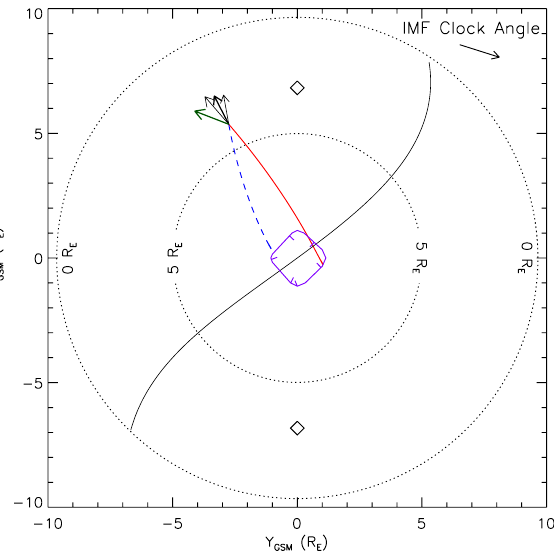
Fig. 10. ( a : left) PEACE electron data from Cluster 2 for FTE 167 (8 April 2003, 03:57 UT). The top three panels are spectrograms showing the differential energy flux of electrons moving parallel, perpendicular and antiparallel to the magnetic field respectively. The bottom two panels show the normal component of the magnetic field and the magnetic field strength observed by all four spacecraft in standard Cluster colours (C1: black, C2: red, C3: green, C4: blue). This event is an exam- ple of a straightforward electron signature (accelerated magne- tosheath plasma antiparallel to the magnetic field, indicating a connection to the Northern Hemisphere). ( b : above) The Cool- ing model run for this event, in the same format as Fig. 7. The observed velocity was consistent with the model de Hoffmann- Teller velocity for a flux tube connected to the Northern Hemi- sphere. This is consistent with the antiparallel electron signa- ture observed by